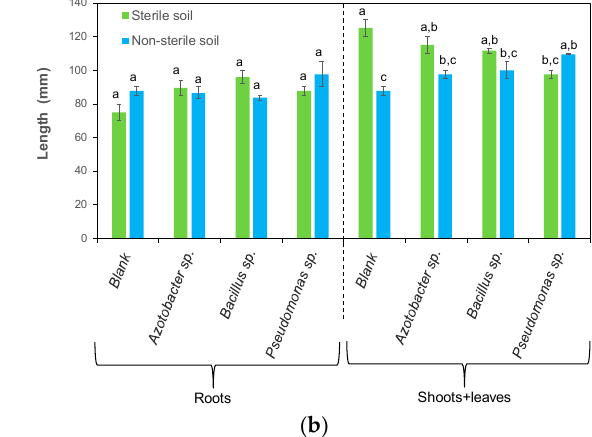
( b ) Figure 4 . Effects of Azotobacter , Bacillus and Pseudomonas species on Brassica napus L.: ( a ) visual as- pect of plants and ( b ) the root and shoot/leaf length (error bars represent the experimental error; means that do not share a letter are significantly different according to the Tukey’s HSD test). The studies performed to establish the effects of Azotobacter , Bacillus and Pseudomo- nas species on the growth of Amaranthus retroflexus L. plants showed that their develop- ment in the sterile soil was more efficient than in the non-sterile soil (Figure 5a). The shoots of the plants from the sterile soil were shorter by 23.97%, 28.91%, 4.44% and 13.64%, respectively, compared to the shoots of the plants grown in non-sterile soil. It was also found that Azotobacter sp. had an inhibitory effect on the plants grown in the sterile soil, assuming that this bacteria species did not promote the growth of Amaranthus retroflexus L. In the non-sterile soil, no significant difference was observed between the root and shoot length of Amaranthus retroflexus L. inoculated with Azotobacter of uninoc-